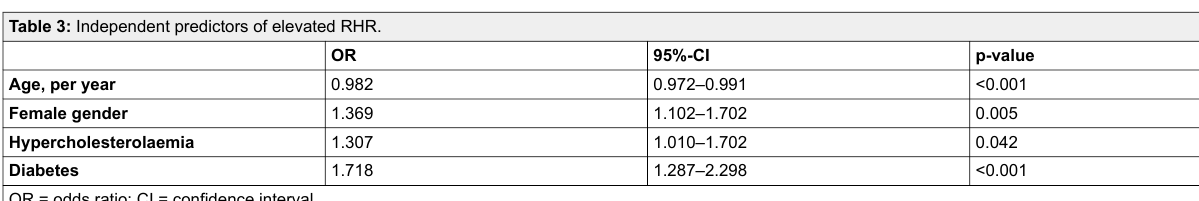
Table 3: Independent predictors of elevated RHR.